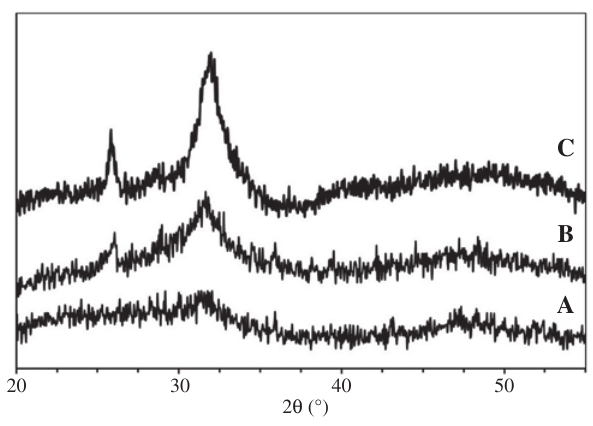
Figure 5 XRD patterns for the composite microsphere sample before and after immersion into SBF: (A) before immersion in SBF, (B) after 7 days in SBF, and (C) after 14 days in SBF. at 795 cm -1 corresponded to the symmetric stretch of